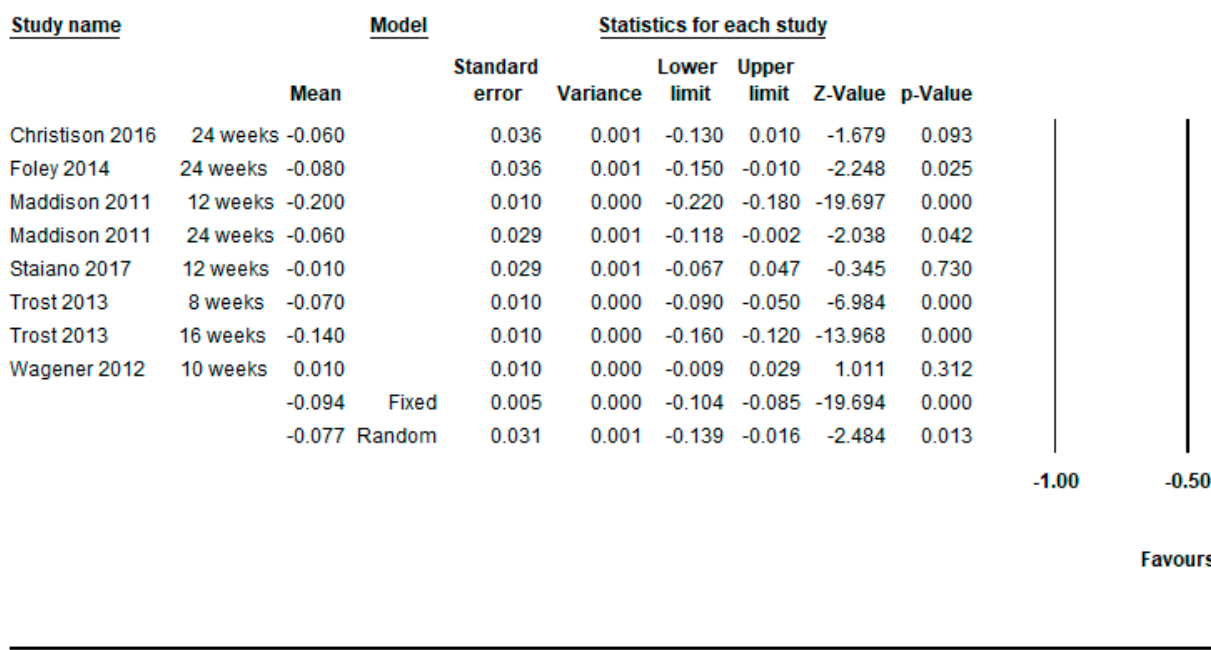
Figure 11. Pre-post difference of BMI between groups. Only BMI z-score and all follow-ups. Table 7. Global heterogeneity between groups. Only BMI z-score and all follow-ups. Difference between Groups. IMC z-Score.